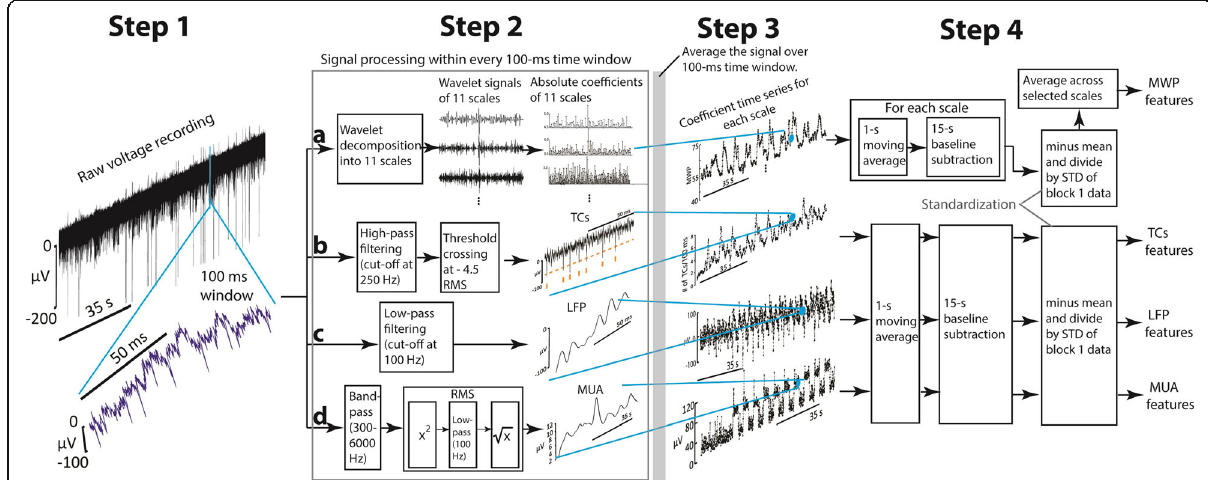
Fig. 2 Processing of raw signal into different neural features. Step 1 : A 100 ms section of neural signal was selected from a larger raw voltage recording. Step 2 : Conduct signal processing for this 100 ms raw signal. In method a ), raw signal was decomposed into 11 wavelet scales to get the rectified wavelet coefficients of each scale; In method b ), a high-pass filter and threshold of - 4.5 times of the RMS value was applied to detect the TCs within this 100 ms section of raw signal; In method c ), a low pass filter was applied to get LFP of the raw signal; In method d ), band pass filter and customized RMS values were calculated to get MUA of the raw signal. Step 3 : The processed signal within this time window were then averaged over this 100 ms, respectively, to compose the related one data point in the averaged larger time series of an entire block. Step 4 : Signal smoothing and standardization. To generate MWP feature time series, a 1-s moving average and a 15-s wide mean subtraction were applied to this averaged time series of the entire block. Afterwards, the processed time series were standardized and averaged accordingly across selected scales to produce a new time series for each channel. To generate other feature time series, the processed signal after Step 3 was applied 1-s moving average, a 15-s mean subtraction and standardization, sequentially (Please refer to the Methods section for more